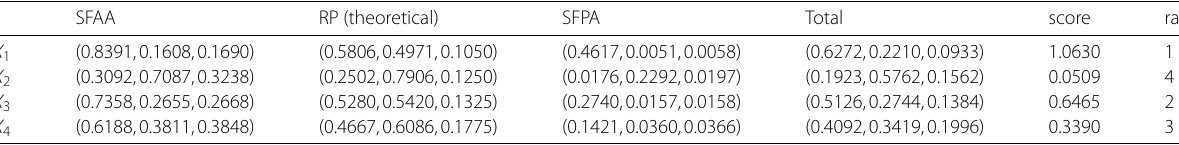
Table 2 The results of the personnel selection problem using theoretical reference point SFAA